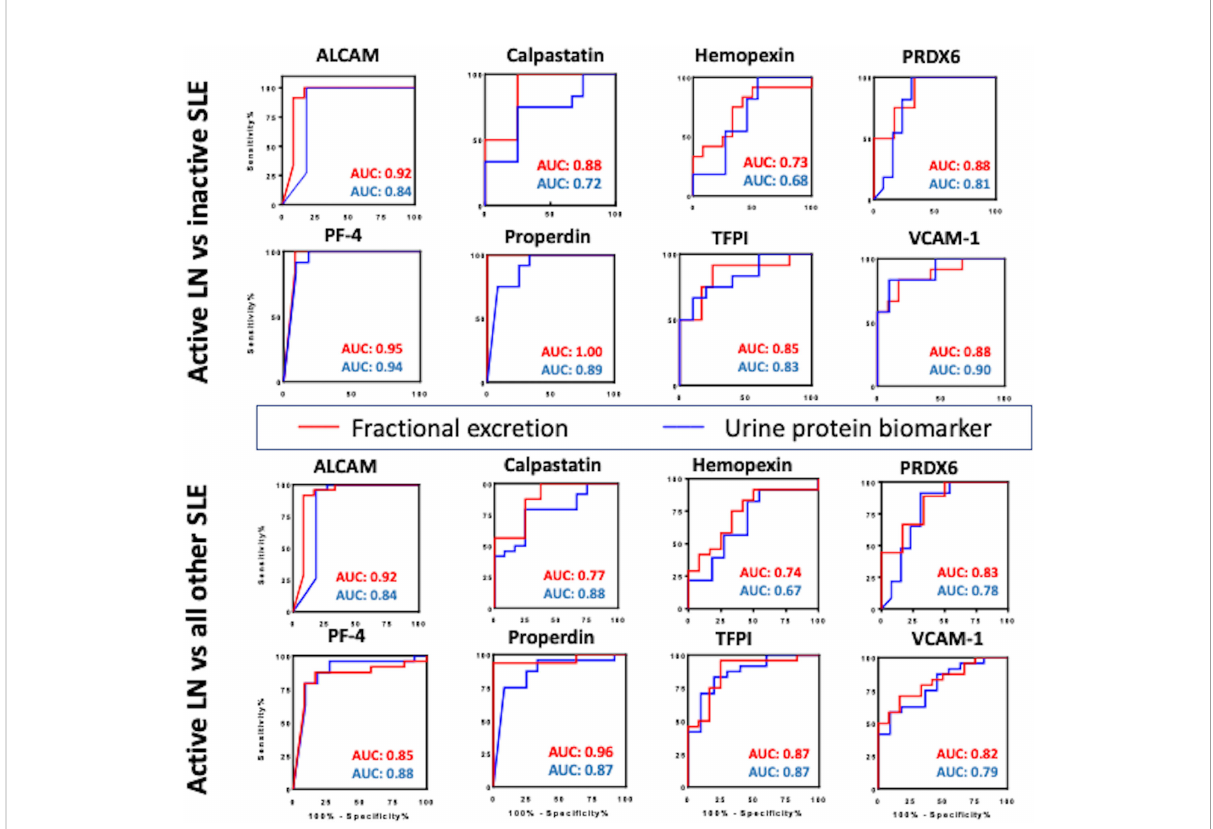
FIGURE 5 Comparing the diagnostic potential of FE ratios and their corresponding urine biomarkers in identifying active LN. Receiver Operating Characteristic (ROC) curves were generated for the 8 urine protein markers (blue line) and their corresponding FE ratios (red line) in differentiating active lupus nephritis from inactive SLE (top) and active lupus nephritis from all other SLE patients (active non-renal and inactive SLE) (bottom). The 95% con fi dence intervals, sensitivity and speci fi city values for these markers are detailed in Table